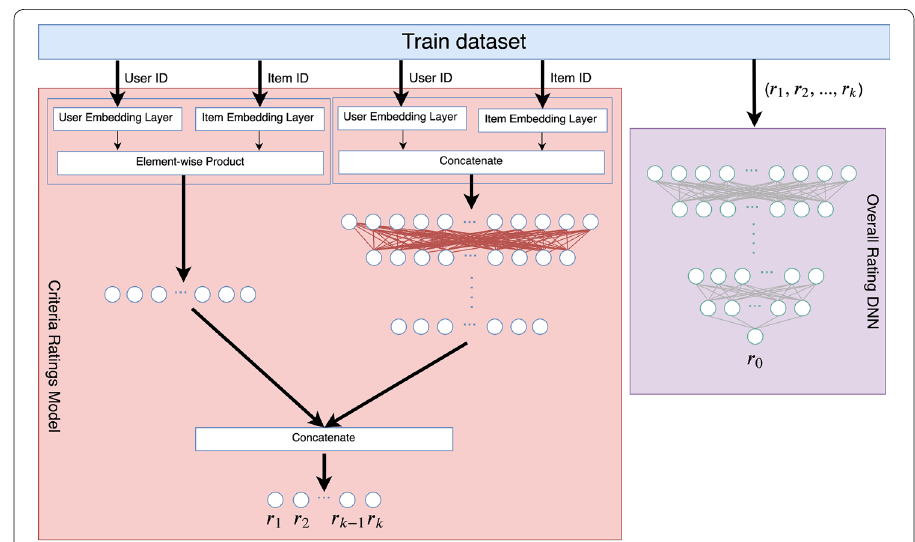
Fig. 2 The architecture of the two models: Criteria Ratings Model and Overall Rating